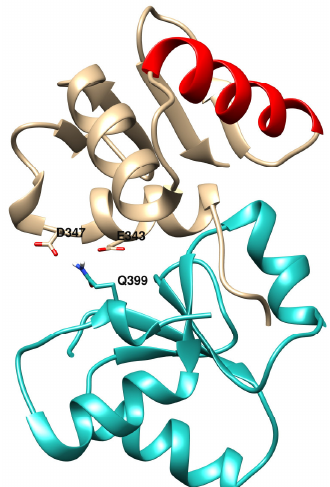
Figure 6. First model of the docking of the ETS domain of Ets-1 (top) and the first BRCT domain of XRCC1 (bottom). At the interface, the Q399 variant of XRCC1 is depicted in stick as well as the two negatively charged amino acids D347 and E343 of ETS. The DNA-binding helix H3 of ETS(Ets-1) is colored red.